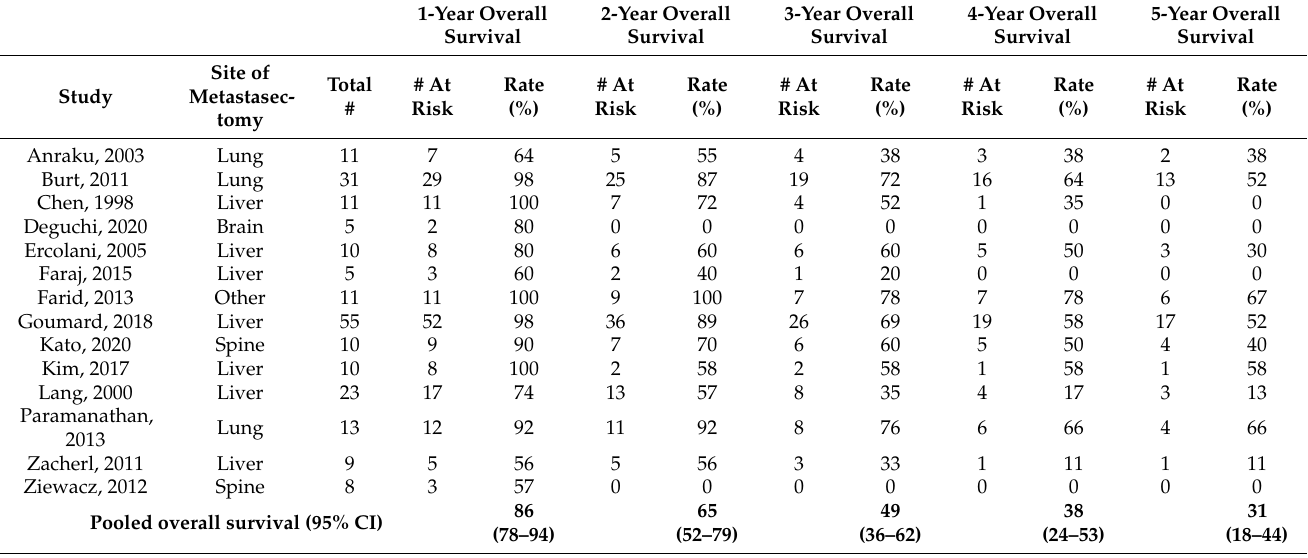
better than those undergoing brain and spine metastasectomy (Figure 1). Table 5. Pooled overall survival estimates.